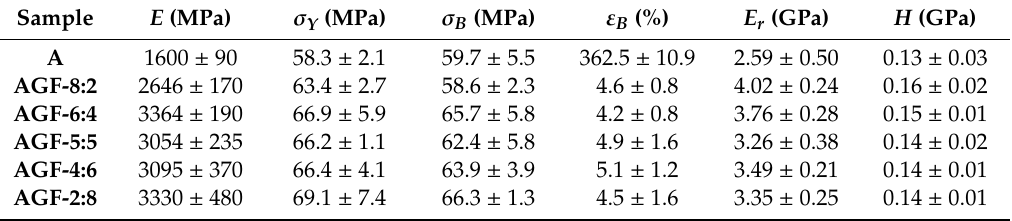
Table 10. Mechanical properties of virgin PETG filled with EG and